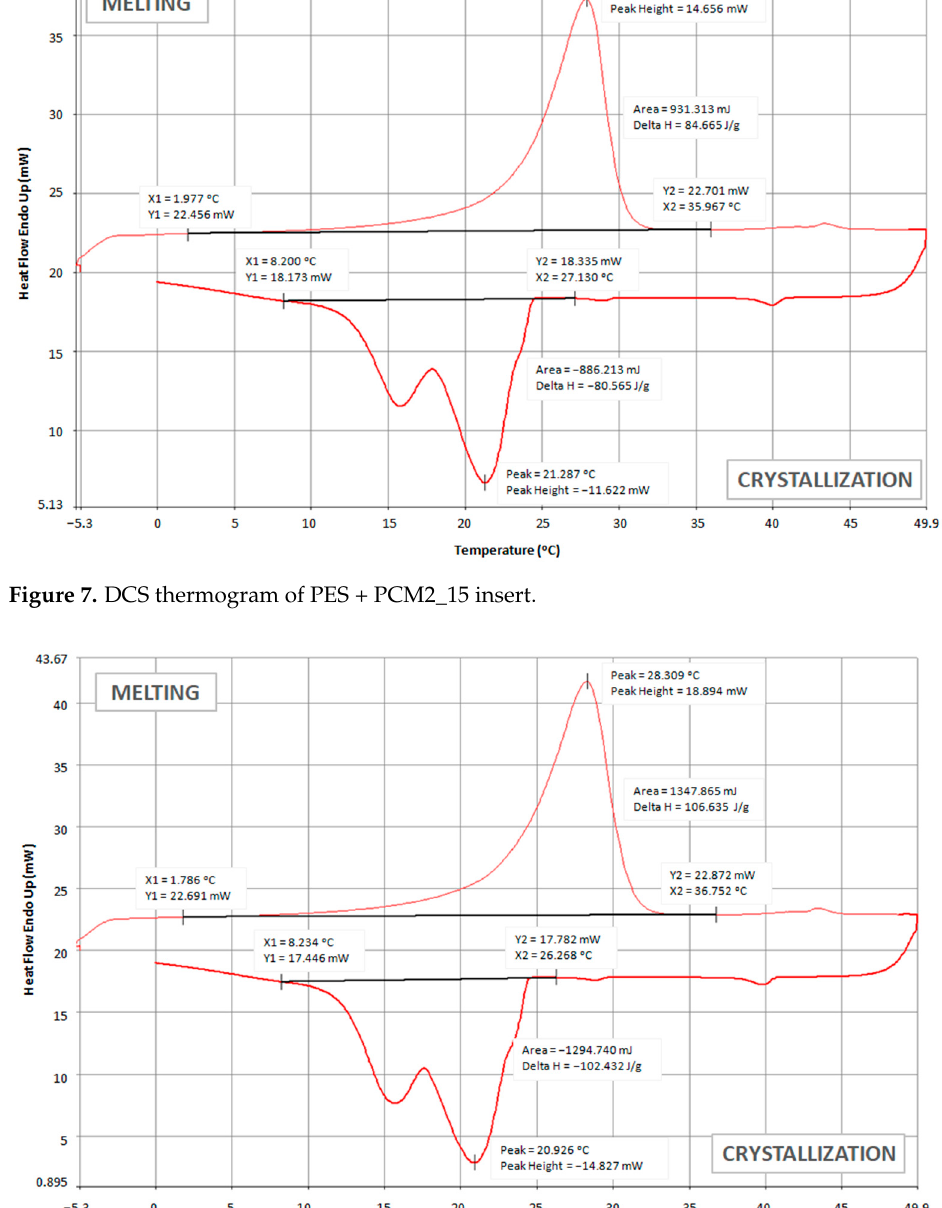
Figure 6. DCS thermogram of PES + A2_10 + PCM2_7.5 insert.